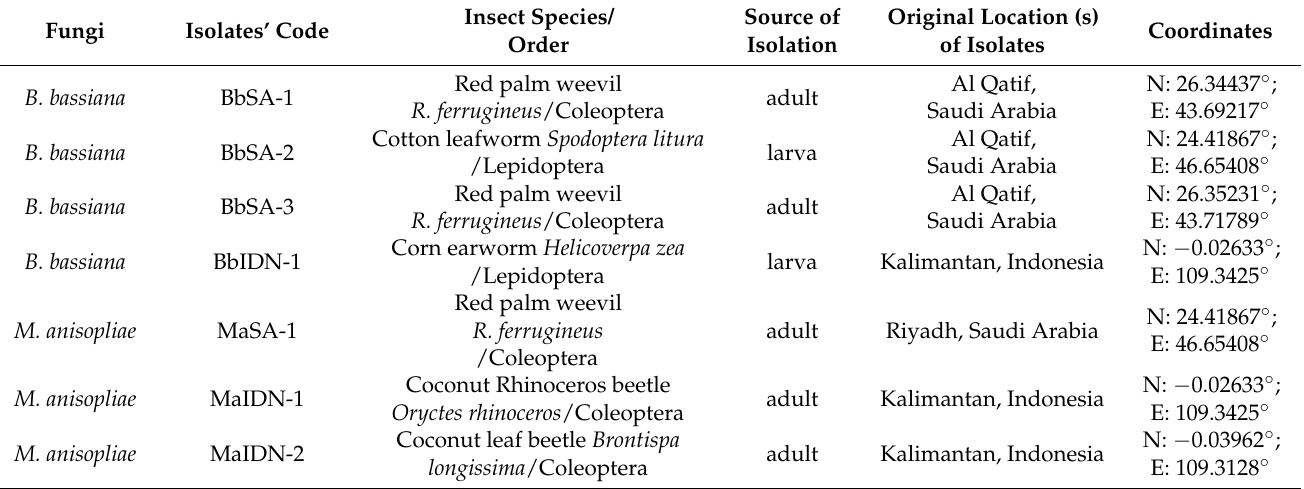
Table 1. Background information on the entomopathogenic fungal isolates used in the present